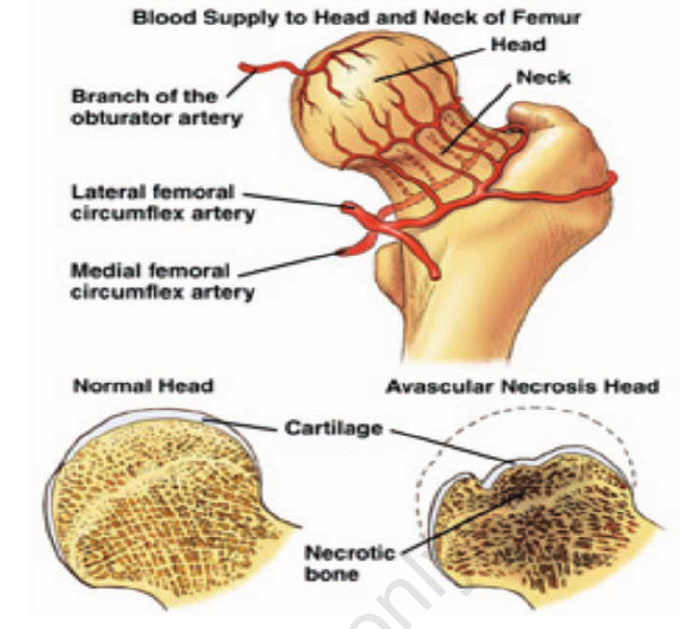
Figure 11. Avascular necrosis (osteonecrosis) of bone. Avascular necrosis of the hip occurs when blood flow to the top portion of the thighbone (femur) is interrupted. The affected portion of the bone consists of the head (the ball-shaped piece of bone that fits into the socket of the hip) and neck (the portion of the thighbone just below the head). When it’s deprived of blood, this part of the bone begins to “die,” breaking down and causing the cartilage on top of it to